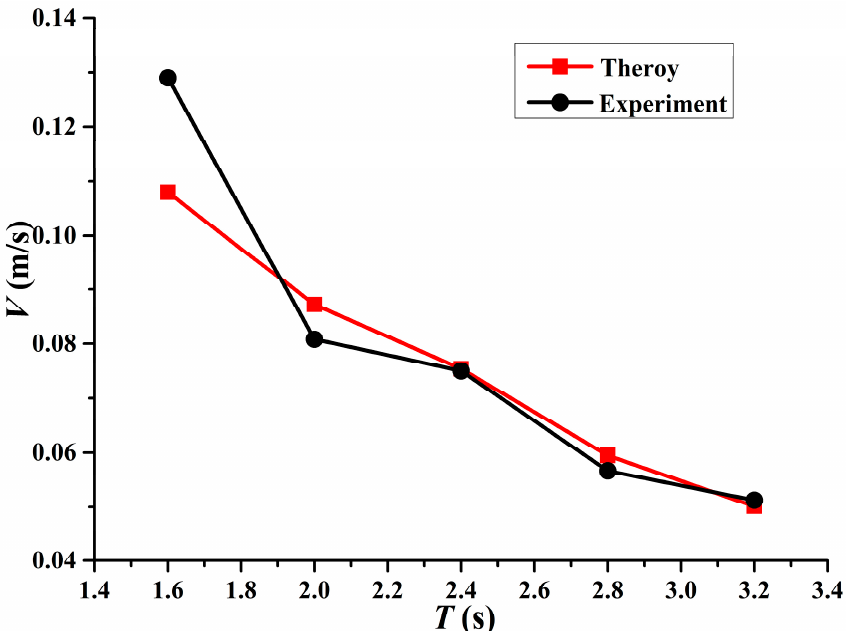
Figure 21. Theoretical speeds and experimental measurement speeds of the robot in different stroke cycles T .